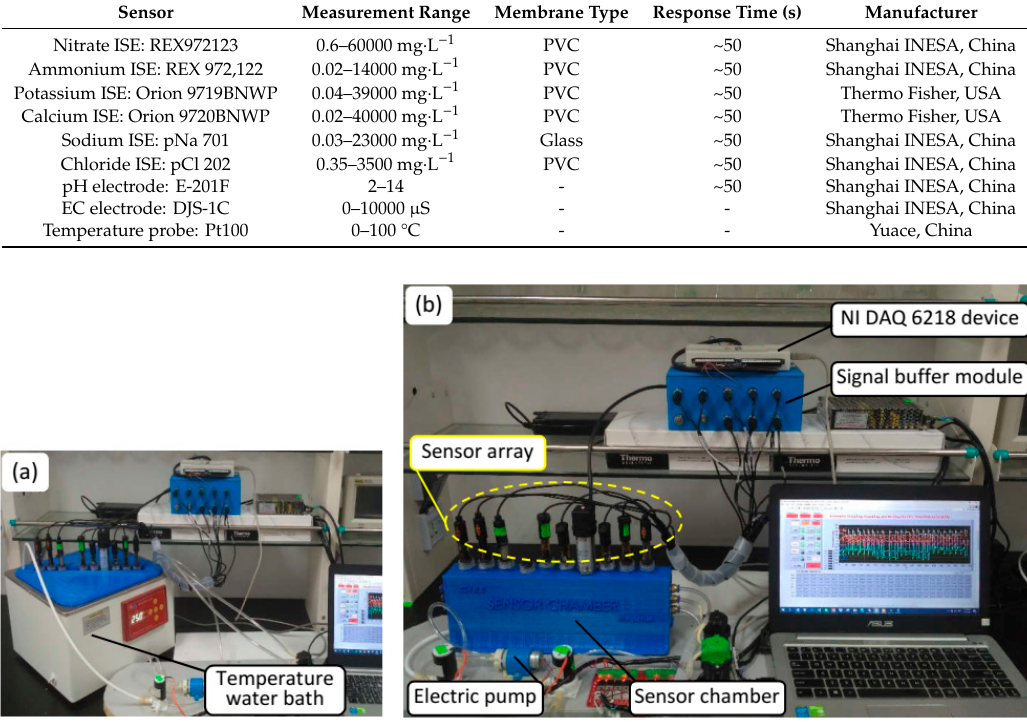
Figure 2. Temperature calibrating water bath ( a ) and the measurement system used in this study ( b ).